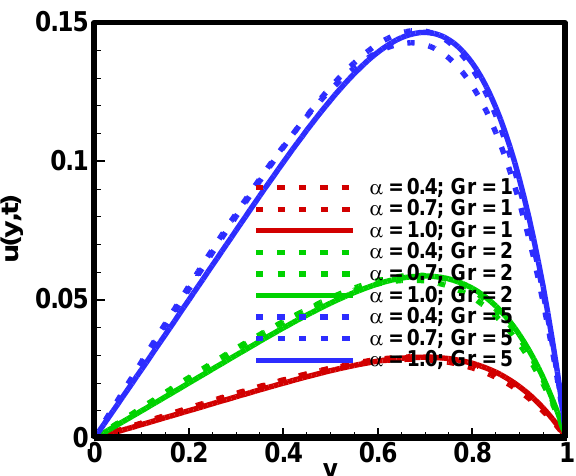
= 0.1, Ha = 5, λ β = 0.1, Pr = 21, 2 1